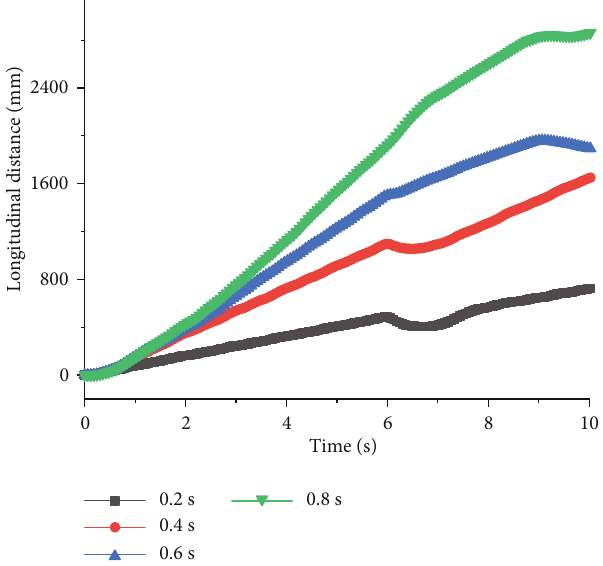
Figure 10: Longitudinal distances of quadruped robots with full elbow joint with di ff erent period at a constant